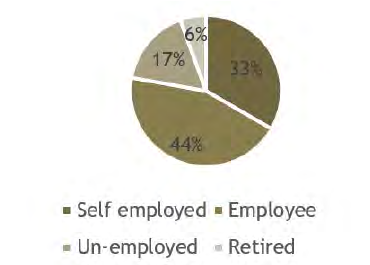
Figure 6. Occupational